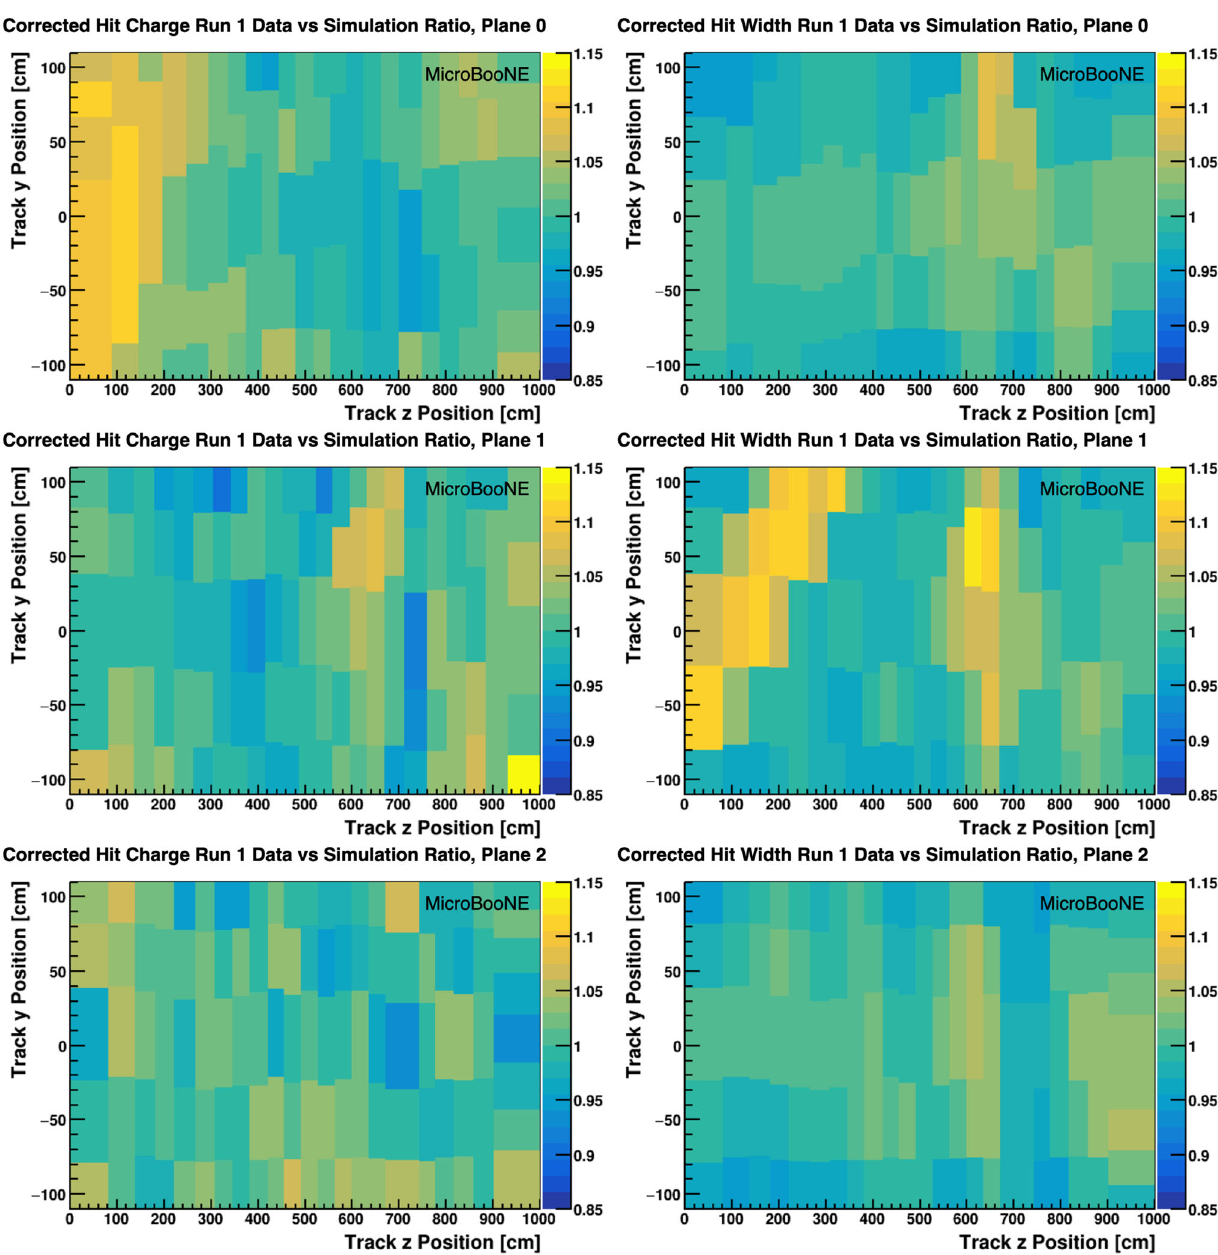
Fig. 7 Ratios (data/simulation) for hit charge and width vs. ( y , z ) . The left column shows the hit charge; the right column shows the hit widths. The top row shows the ratios on the first induction plane; the middle